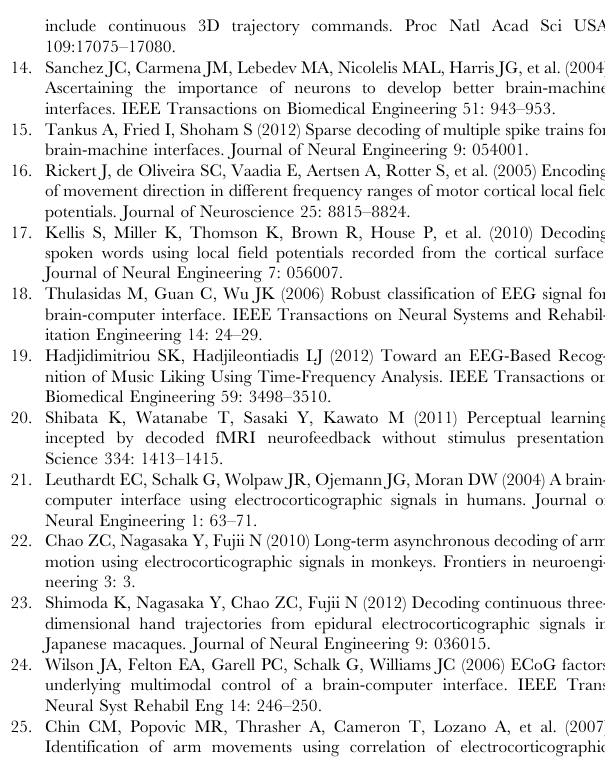
Figure S1 Predictive error sum of squares in model training for monkey A. The blue line and green line show predictive error sum of squares (PRESS) and R2 values, respectively, for different numbers of latent variables used in the PLS model. The optimal number of 20 is denoted with the red dotted line. Figure S2 Decoding results using 15 electrodes for monkey A. Example of prediction of 3D hand positions during 100 seconds test data by using 15 channel ECoG signals. The R2 value between the predicted (blue) and observed (red) trajectories for X-, Y-, and Z-positions are shown.